Question: What type of chart is this?
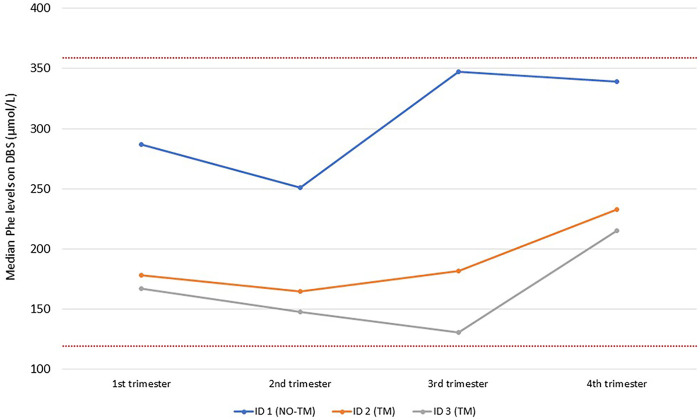
Answer: line